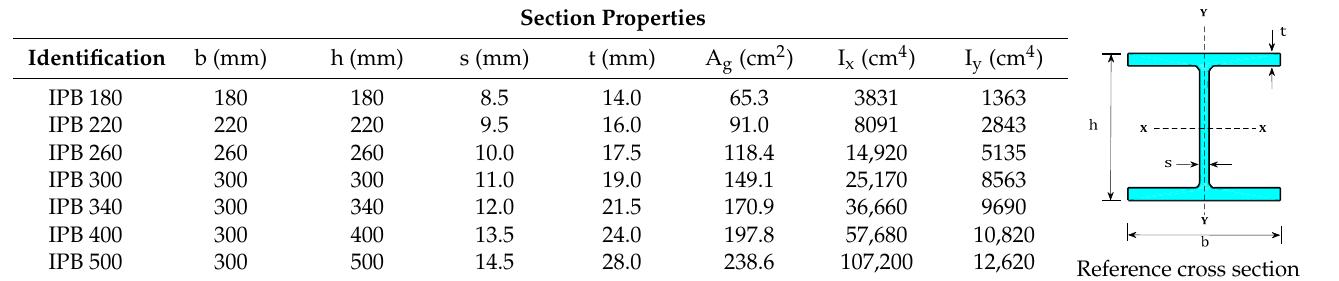
Table 2. Geometrical properties of selected H-sections for parametric FE simulations.